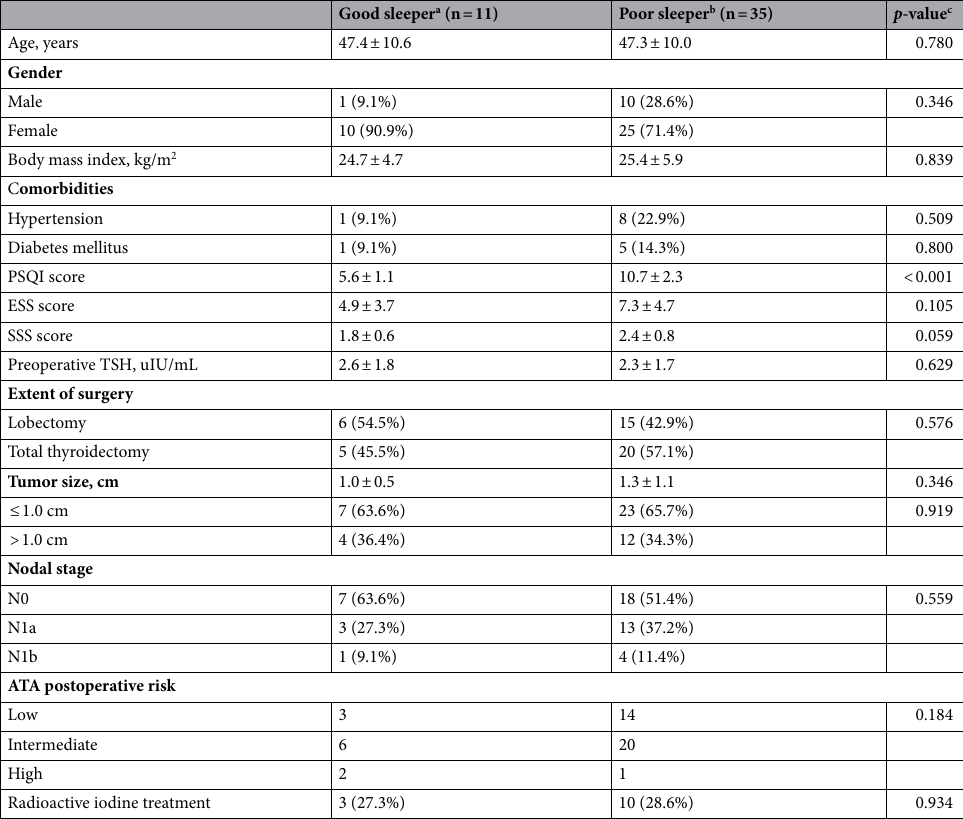
Table 1. Clinicopathological characteristics of preoperative good and poor sleepers. PSQI Pittsburgh sleep quality index, ESS Epworth sleepiness scale, SSS Stanford sleepiness scale, TSH thyroid stimulating hormone, ATA American thyroid association. a Good sleeper was defined as a patient who had a PSQI score of 7 or less. b Poor sleeper was defined as a patient who had a PSQI score greater than 7. c p -values from the Mann–Whitney U test between good and poor